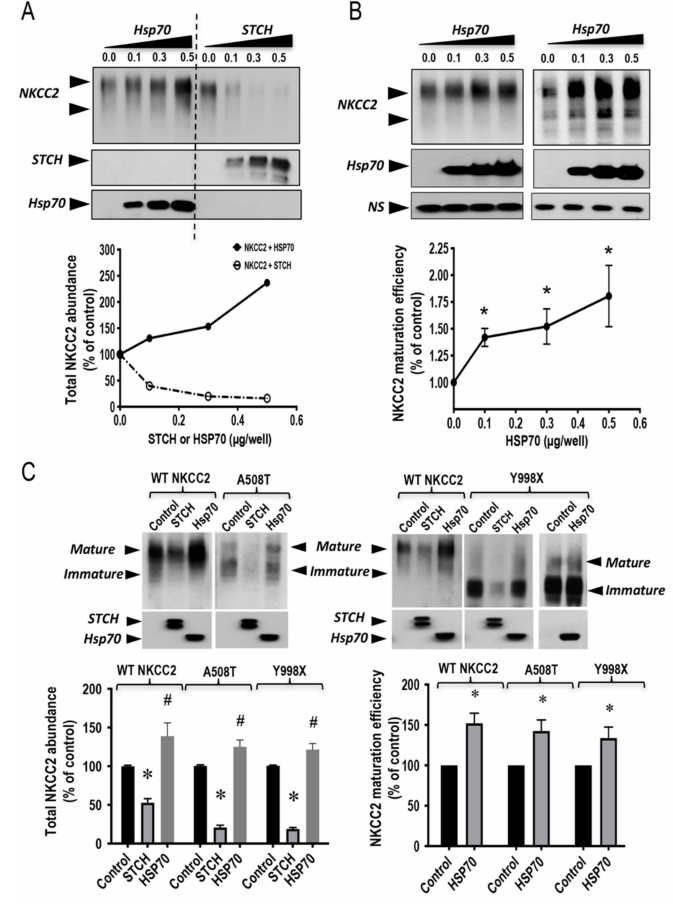
Figure 7. STCH and Hsp70 differentially regulate NKCC2 and its disease-causing mutants. ( A ) Rep- resentative immunoblot of two independent experiments showing opposite effects of STCH and Hsp70 on NKCC2 protein abundance. HEK cells were co-transfected with Myc-NKCC2 (0.1 µ g/well) and increasing amounts of GFP-STCH (0.1–0.5 µ g/well) or Myc-Hsp70 (0.1–0.5 µ g/well) as indicated. NKCC2, Hsp70, and STCH proteins were detected by immunoblotting with anti-Myc and anti-GFP anti-bodies. Lower panel , densitometric analysis of total NKCC2 proteins. Data are expressed as a percentage of control ( n = 2). ( B ) Hsp70 co-expression increases NKCC2 maturation efficiency. Upper panel , two representative immunoblots illustrating the effect of Hsp70 overexpression on NKCC2 protein abundance and maturation in HEK cells. Cells were transfected with Myc-NKCC2 alone (0.1 µ g/well) or in the presence of Myc-Hsp70 (0.1–0.5 µ g/well). Then, 24–48 h post-transfection, total cell lysates were subjected to immunoblot analysis for NKCC2 and Hsp70 proteins using anti-Myc. NS , a non-specific band illustrating the equal loading of protein extracts. Lower panel , densitometric analysis of the maturation efficiency (ratio of the mature vs. immature form of NKCC2) of WT NKCC2 in the presence or absence of Hsp70. Data are expressed as percentage of control ± S.E. Each point represents mean ± SE from three independent experiments ( n = 3). *, p < 0.05 versus control. ( C ) Differential regulation of NKCC2 mutants by STCH and Hsp70. HEK cells were transiently transfected with NKCC2 or BS1 mutants (A508T or Y998X) in the presence or absence of STCH or Hsp70, as indicated. NKCC2, Hsp70, and STCH proteins were detected by immunoblotting with Myc antibody and anti-GFP. Lower right panel , densitometric analysis of total NKCC2 proteins. Data are expressed as a percentage of control. * and #, p < 0.05 versus control. NKCC2 alone, n = 6. NKCC2 with STCH, n = 5. NKCC2 with Hsp70, n = 5. A508T alone, n = 4. A508T with STCH, n = 3. A508T with Hsp70, n = 3. Y998X alone, n = 6. Y998X with STCH, n = 3. Y998X with Hsp70, n = 4. Lower left panel , densitometric analysis of the maturation efficiency (ratio of the mature vs. immature form of NKCC2) of WT NKCC2 ( n = 3), A508T ( n = 3), and Y998X ( n = 4), the presence or absence of Hsp70. Data are expressed as percentage of control ± S.E. *, p < 0.05 versus